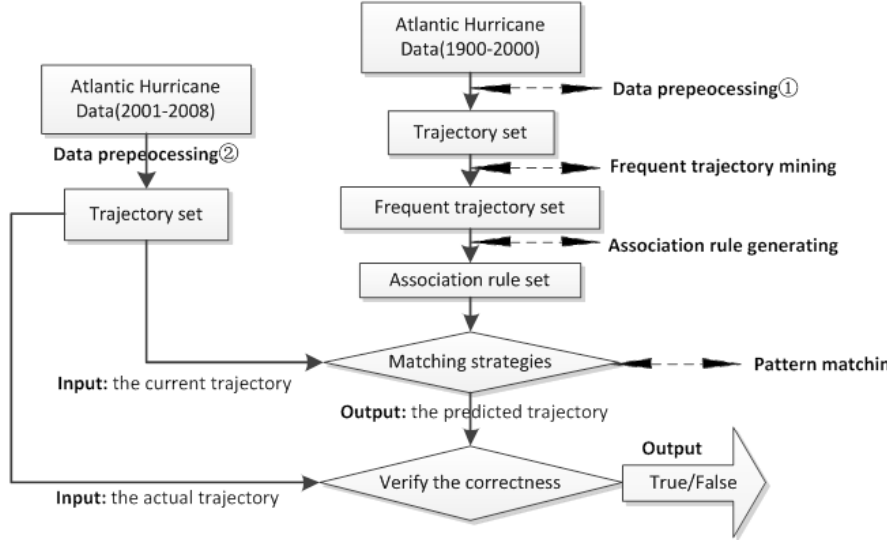
Fig. 1. Prediction system